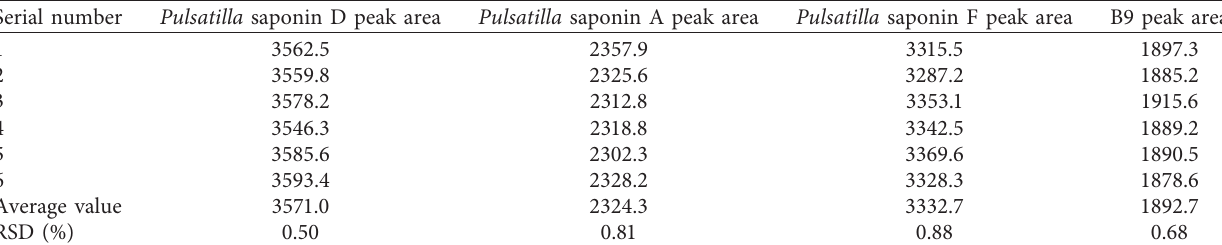
Table 4: The results of